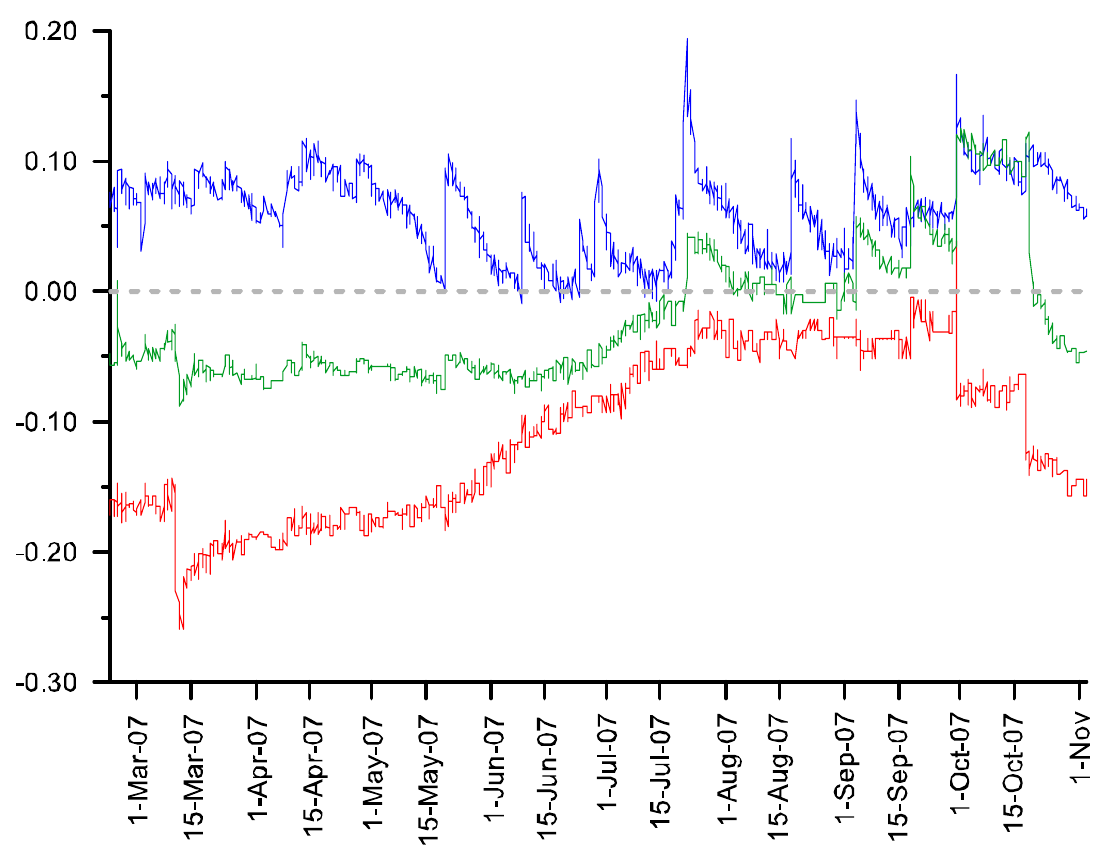
Figure 2. Differences in soil moisture between Plots 2 (control) and 3 (treatment) over time. The soil moisture probe depths are 5 cm (blue), 20 cm (red), and 35/50 cm (green). Positive values indicate that soil moisture is higher in presence of exotic vegetation.